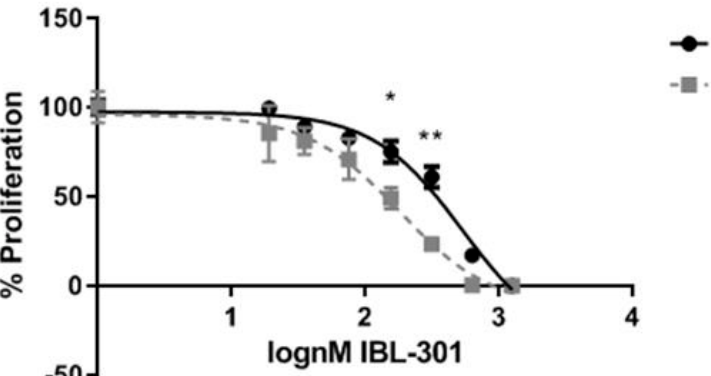
Figure 7. Dose response curves of IBL-301 in H1975GR and matched parent control cell line H1975P. The dose response effect of IBL-301 (0.0195–1.25 µM) on proliferation over 72 h was measured by BrdU assay in the PI3K/mTOR inhibitor resistant cell line (H1975GR) and the age matched parent control cells (H1975P) ( n = 3). The calculated IC50 values were 0.529 µM and 0.179 µM for the H1975GR and H1975P respectively, indicating that H1975GR cells are more sensitive to the triple targeted PI3K/mTOR/PIM inhibitor (* p < 0.05, ** p < 0.01, two-way paired t-test was performed to compare the values between H1975P and H1975GR cells at each concentration).